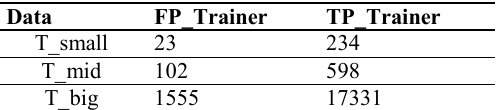
Table 2. Training Time of FP_Tainer and